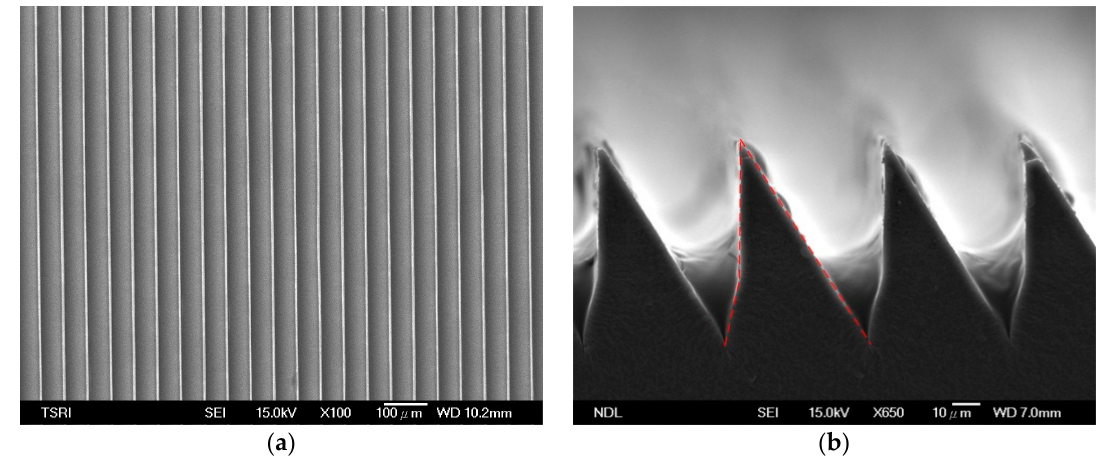
Figure 10. Fabrication result of the PDMS mold. ( a ) Top and ( b ) cross-sectional SEM views.